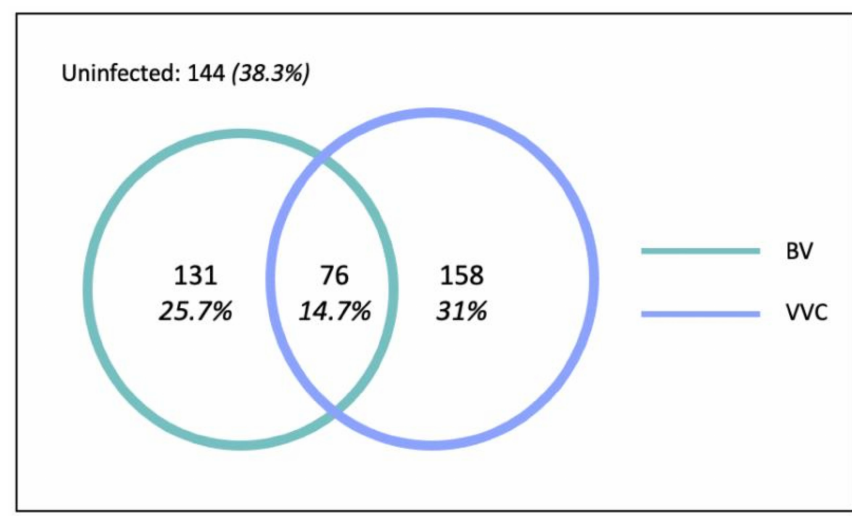
Figure 3. Study population by outcome (N = 509). Circles are proportionate to sample size.